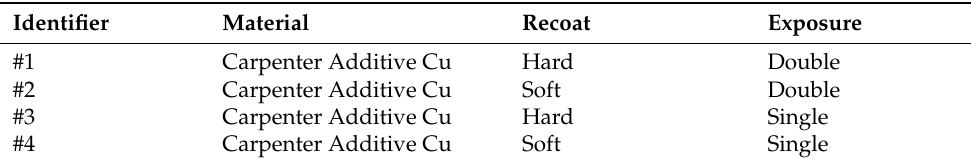
Figure 8. Schematic of laser scanning strategies, where ( a ) is single exposure and ( b ) is double exposure. Table 6. Recoat and exposure study.